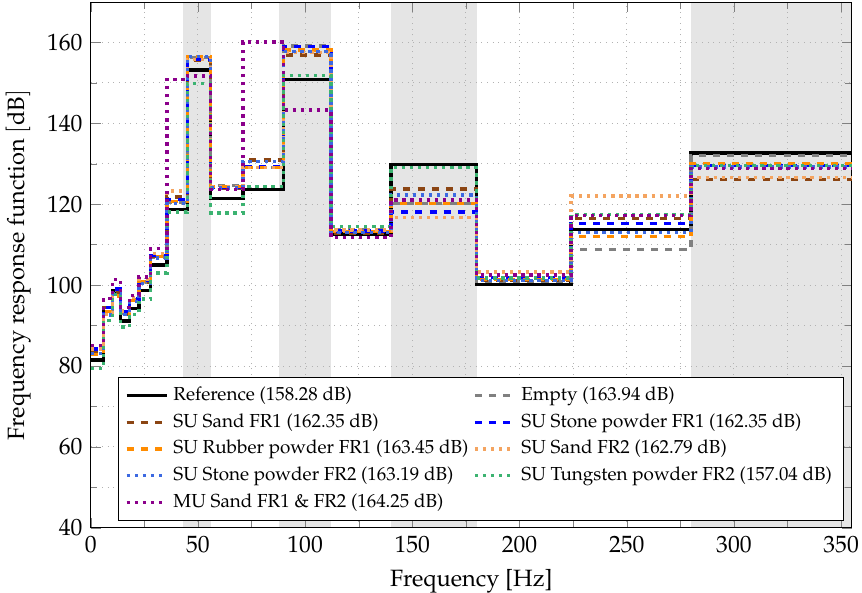
Figure A7. One-third octave band: FRF of SU and MU HCDP mounted between stator arm and stator ring with surface velocity in dB.